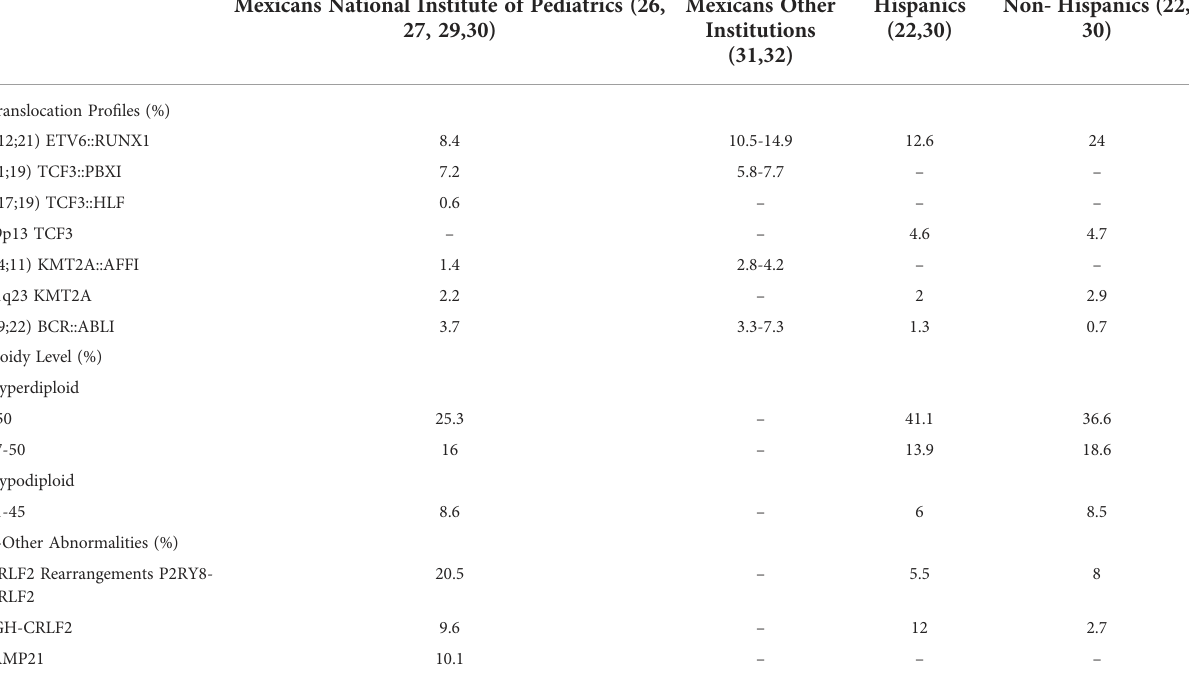
TABLE 1 Comparative incidence of recurrent genetic abnormalities in mexicans, hispanics and non-hispanics children diagnosed with pre-b